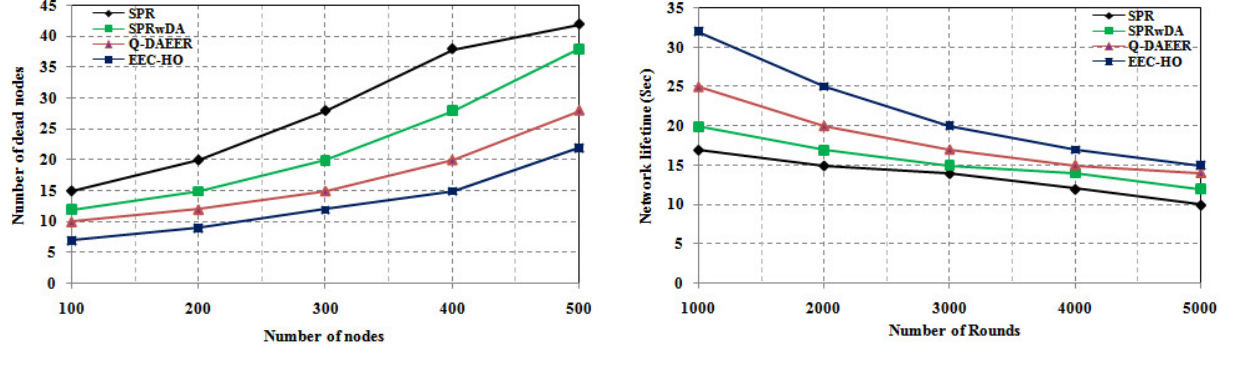
Figure 6. Number of dead nodes with number of nodes